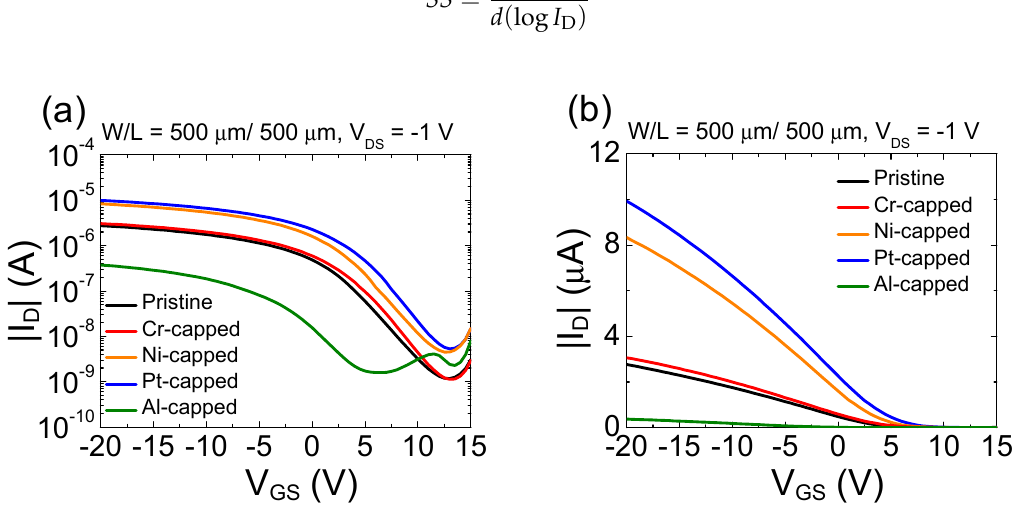
Figure 5. ( a ) Representative transfer curves of the pristine SnO thin-film transistors (TFTs) and the Al-, Ni-, Pt-, and Cr-capped SnO TFTs in the semi-logarithmic scale; ( b ) representative transfer curves of the pristine SnO TFTs and the Al-, Ni-, Pt-, and Cr-capped SnO TFTs in the linear scale.